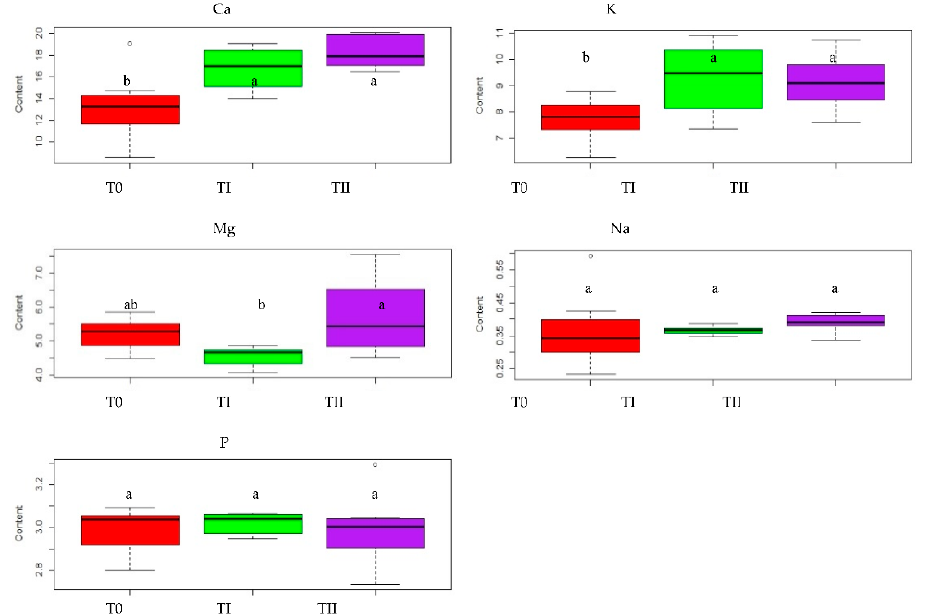
Figure 5. The effect of treating the soil with two amendments on mean Ca, K, Mg, Na and P amounts in oat grown on soils: T0—control soil, TI—soil with compost addition and TII—soil with FA addi- tion. In the figure, the letters denote homogenous